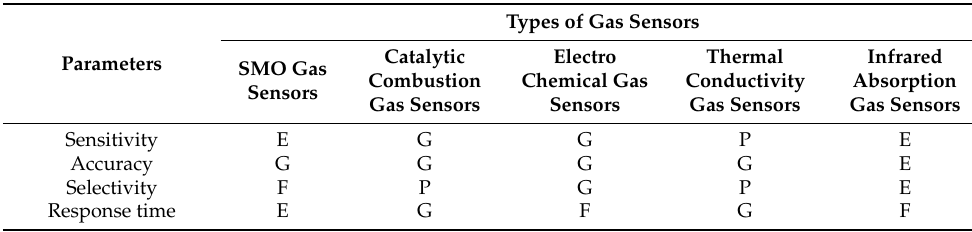
Table 1. Comparison of various types of gas sensors. Reprinted with permission from Ref. [37]. Copyright 2007, Korotcenkov,